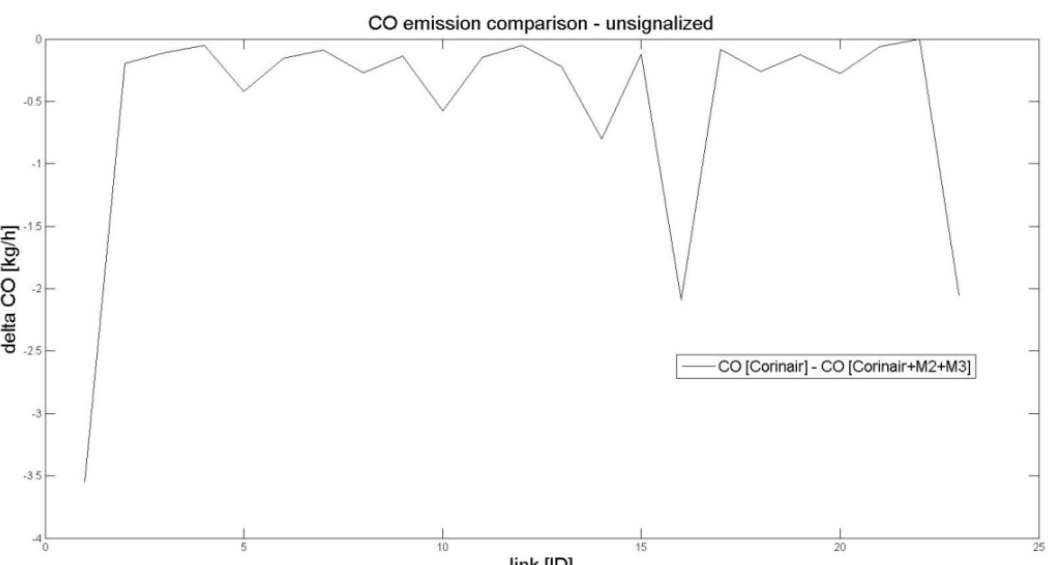
Figure 14. Differences of CO emissions at links approaching unsignalized intersections using CORINAIR or